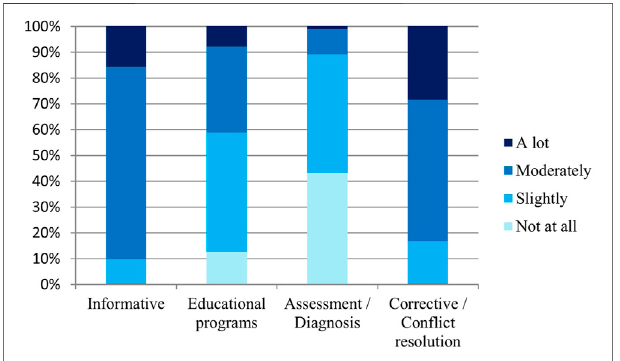
FIGURE 2 | Distribution of intervention models aimed at